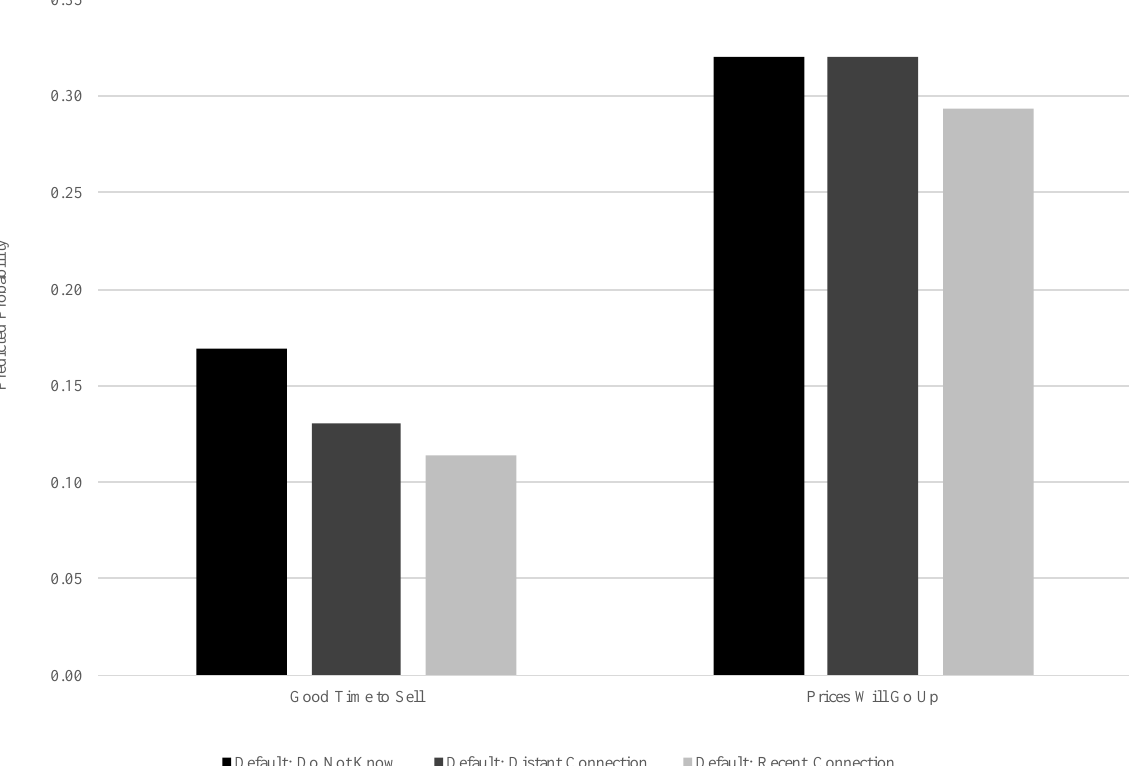
Figure 2: Predicted probabilities for housing market expectations by exposure to mortgage default. Notes : The